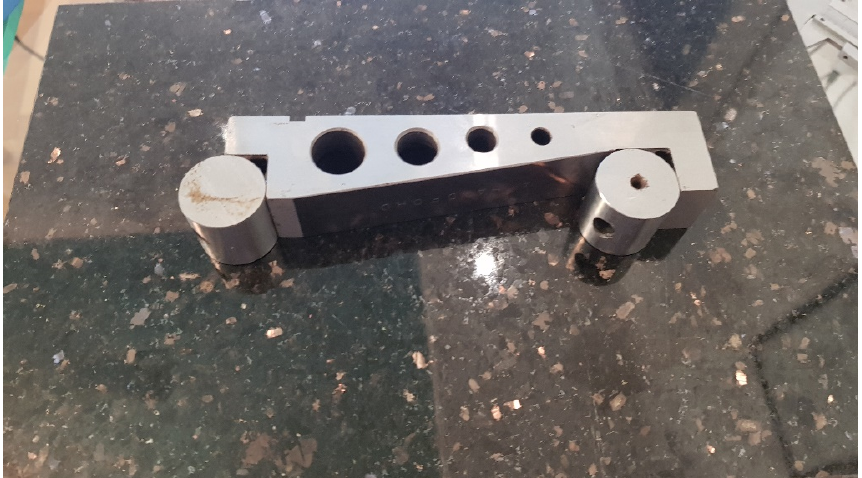
Figure 1. The 5” sine bar and base of granite stone.